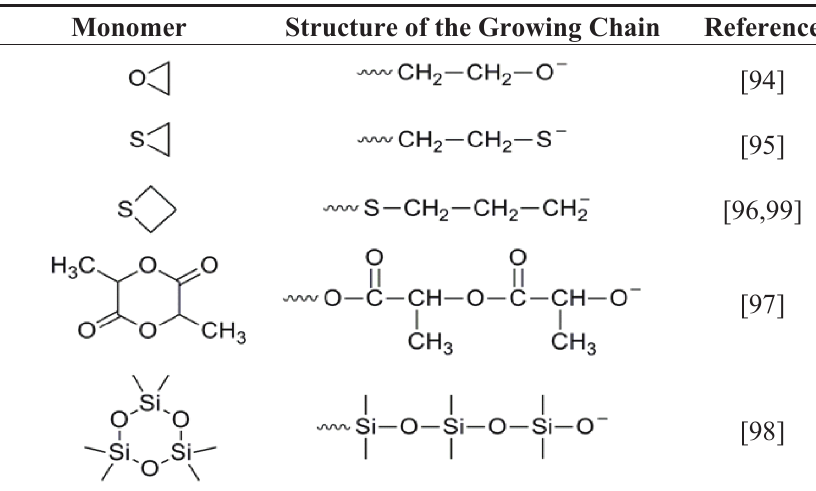
Table 3. Anionically polymerizable heterocycles and the corresponding active species [93 –